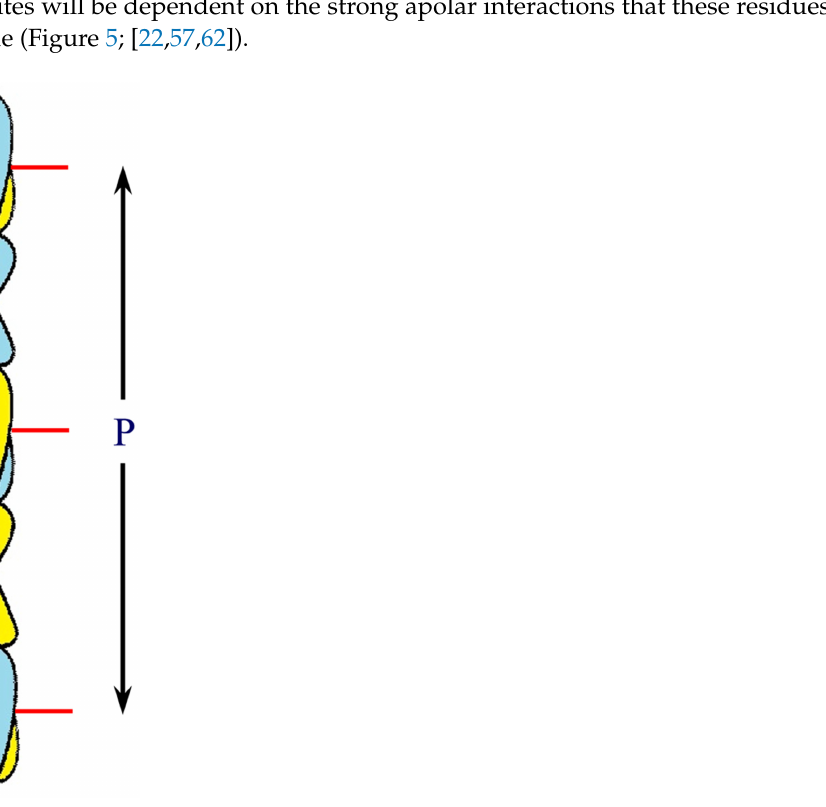
Figure 5. Schematic diagram of the ß-sandwich formed from the conserved 34-residue stretch of sequence in each of two CBP chains. Each sandwich is comprised of a pair of right-handed twisted antiparallel ß-sheets (one is drawn blue and the other is yellow) and these are related to one another by a perpendicular dyad axis of rotation (marked alternatively by red circles and red lines). Axial assembly of the ß-sandwiches through the application of a left-handed four-fold screw axis generates a 3.4 nm diameter filament of pitch length 9.6 nm and axial rise 2.4 nm. Figure reproduced from [58] with permission of